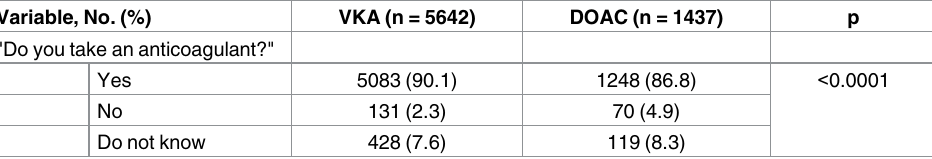
Table 3. Patient’s knowledge of taking an